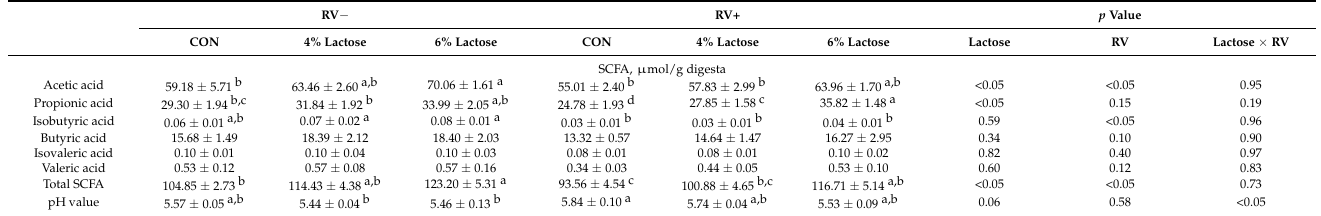
Table 12. Effect of dietary lactose supplementation and/or RV challenge on the levels of short-chain fatty acids (SCFA) and pH value in the cecal digesta of weaned pigs 1